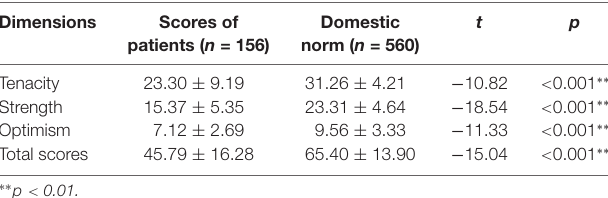
TABLE 3 | Comparison of psychological resilience level in patients with complicated hepatolithiasis and domestic norm ( n = 156, ¯ x ± s).